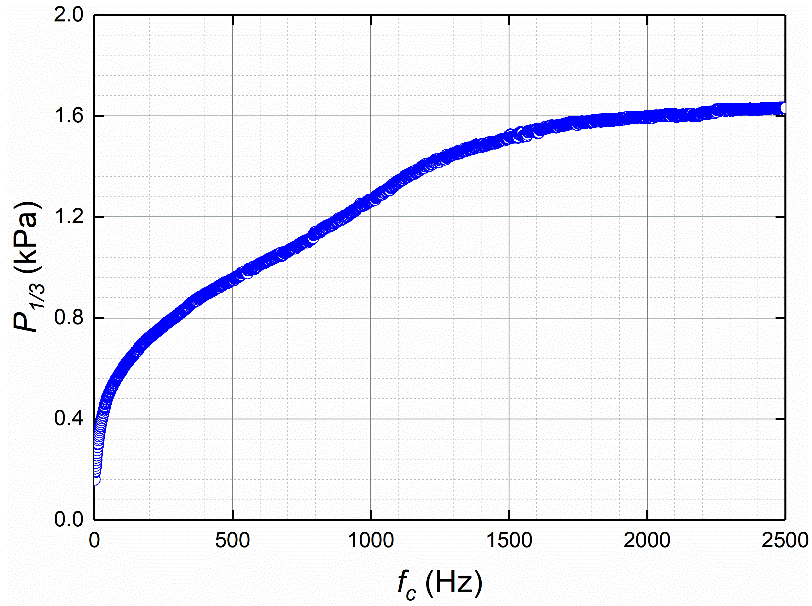
Figure 4. Significant wave pressure P 1/3 of reconstructed wave load time series on PS1 changed with cut-off frequencies f c .